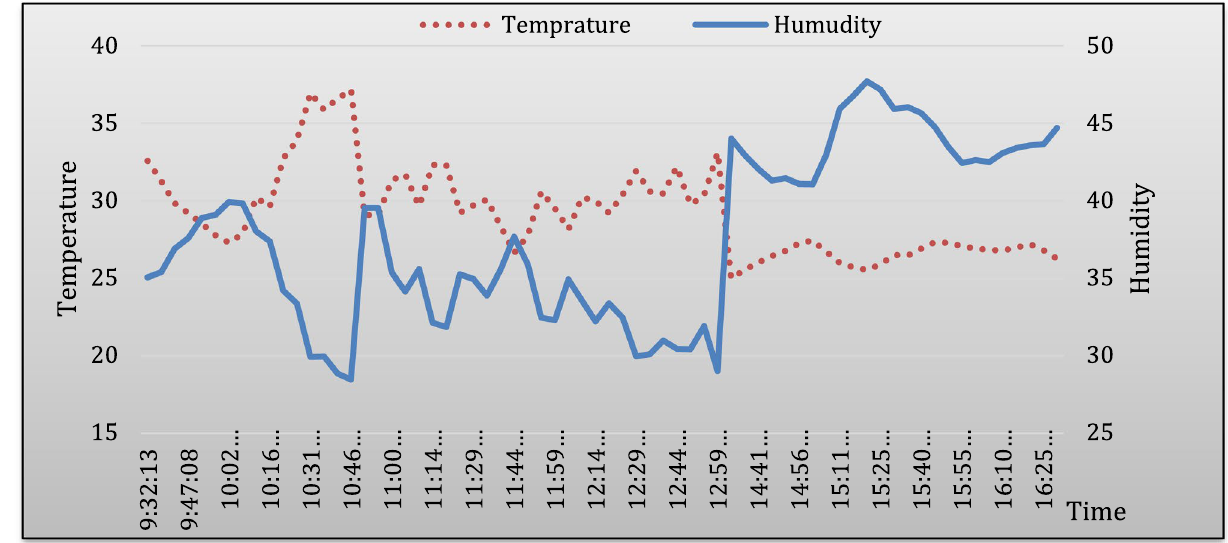
Fig. 6 The results of the experiment carried out on 06.15.2019